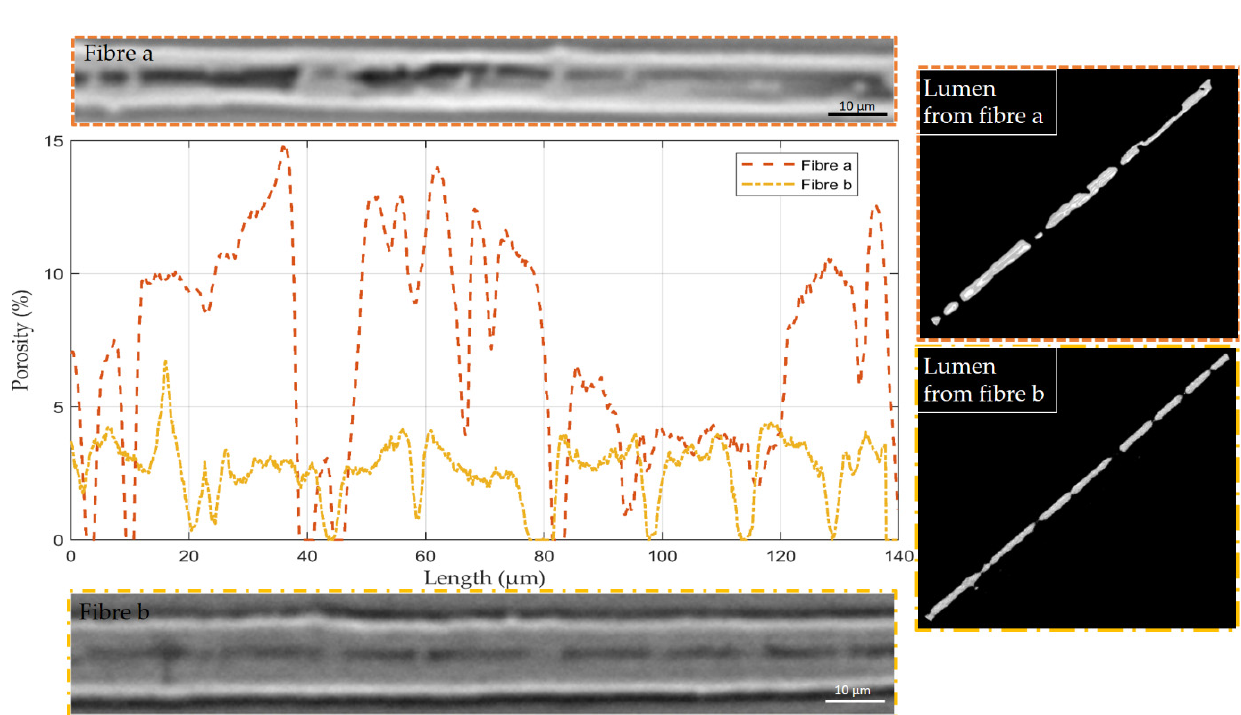
Figure 9. Evolution of the aspect ratio along two flax fibres “a” and “b” and a bundle “c” composed of two fibres “c1” and “c2”, measured from X-ray microtomography data .